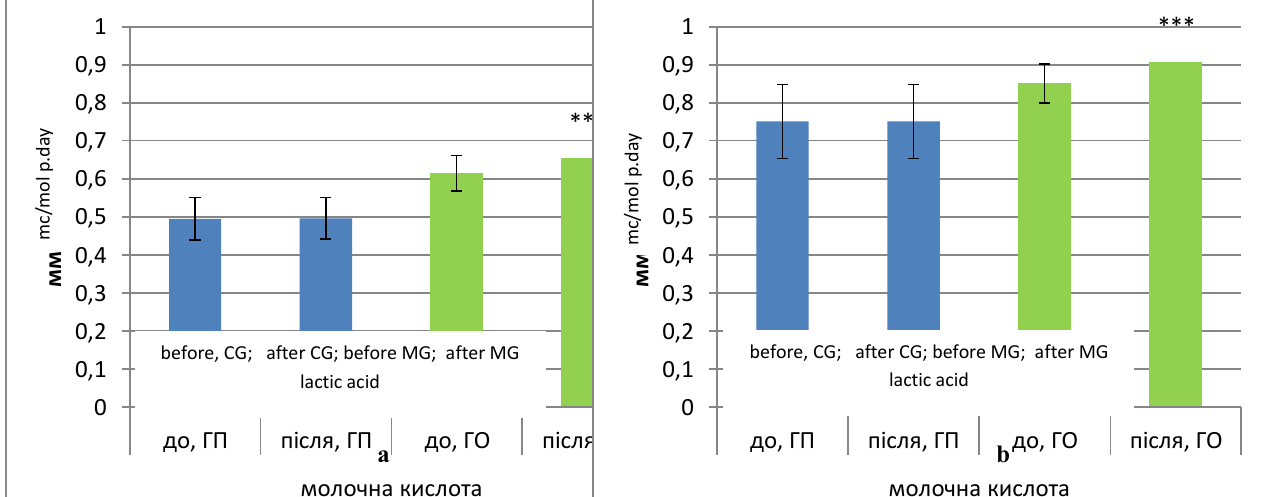
Fig.2. Indicators of bio-chemical monitoring by excretion of lactic acid before and after experiment in a-lactate cluster (of main and comparative groups): a) by bicycle stress test «Vita maxima»; b) by results of control special tests. (*** -р ≥ 0.001). CG – comparative group, MG – main